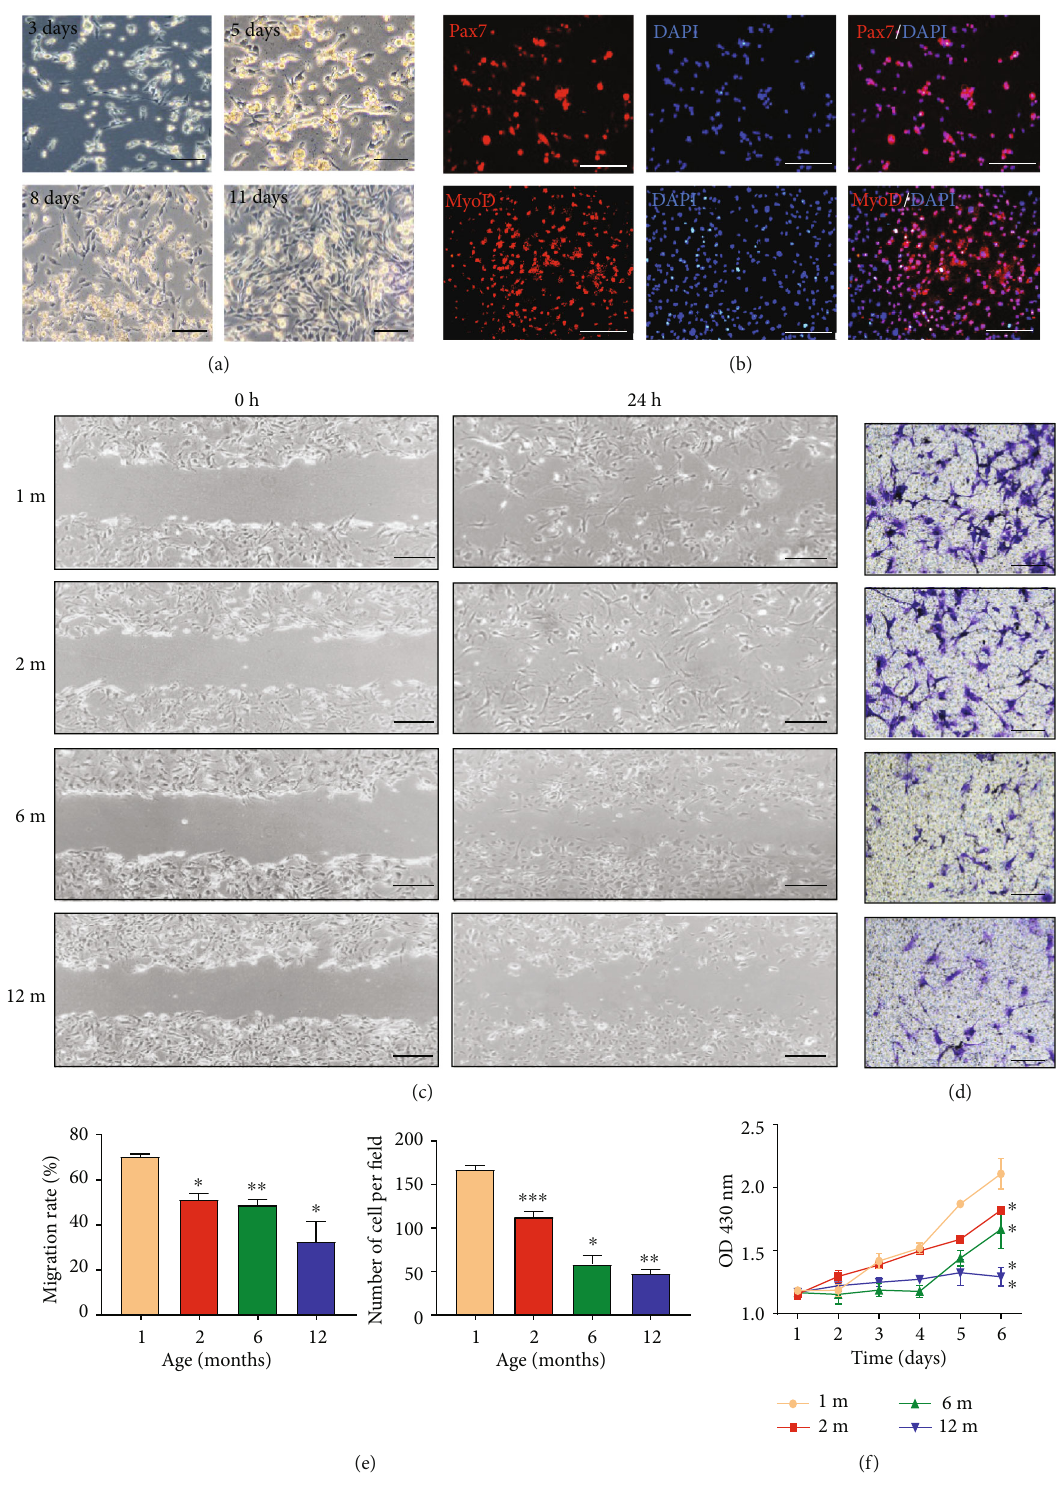
Figure 3: The proliferation and migration of GG MuSCs declined with aging. (a) Primary cells were obtained from GG muscle fi bers, and cells showed a spindle morphology. (b) GG MuSC markers Pax7 and MyoD were positive in cells. (c) Wound healing of GG MuSCs derived from four age groups. (d) The migration of GG MuSCs derived from four age groups. (e) The wound healing and migration rate are signi fi cantly lower in 12-month-old compared to other age groups at 24h. (f) The growth curve of GG MuSCs in four age groups. ∗ p < 0 : 05 and ∗∗ p < 0 : 01 . Scale bars are 100 μ